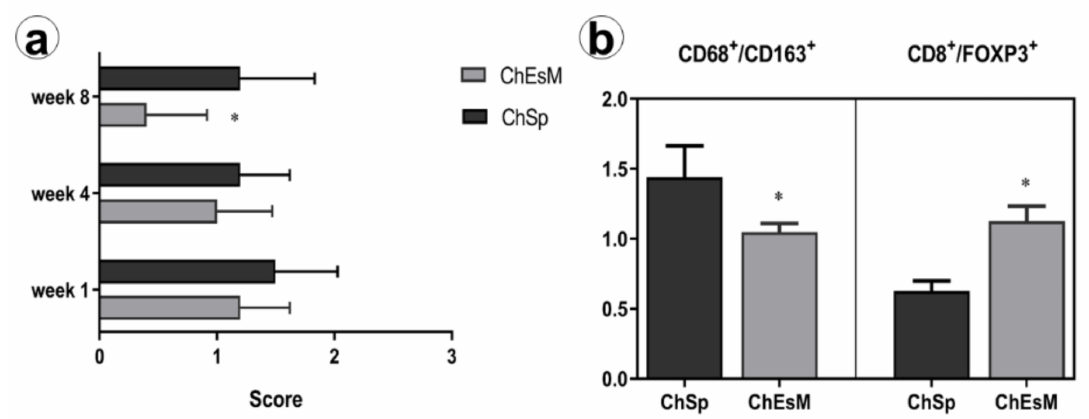
Figure 9. Inflammatory reaction and immune cells ratios in the capsule surrounding hemostatic agents. ( a ) Score of inflam- matory infiltration in the capsule surrounding hemostatic materials and separating them from liver tissues. ( b ) Differences in M1/M2-macrophages and CD8/FOXP3-lymphocytes subtypes ratio in the capsule around ChSp and ChEsM; *—significant difference ( p ≤ 0.05) between two groups.